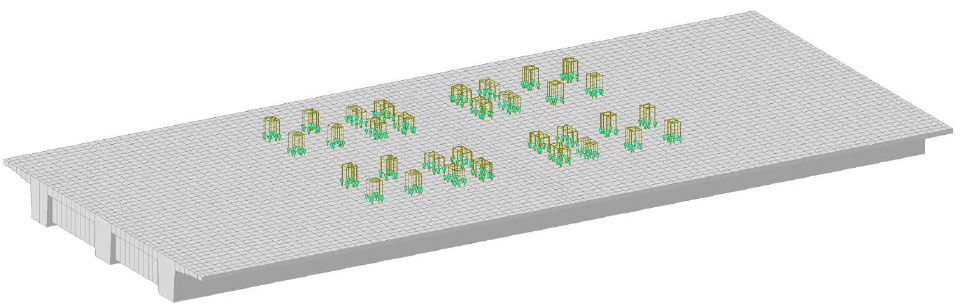
Figure 12. Numerical model of WG-4 superstructure with truck load.